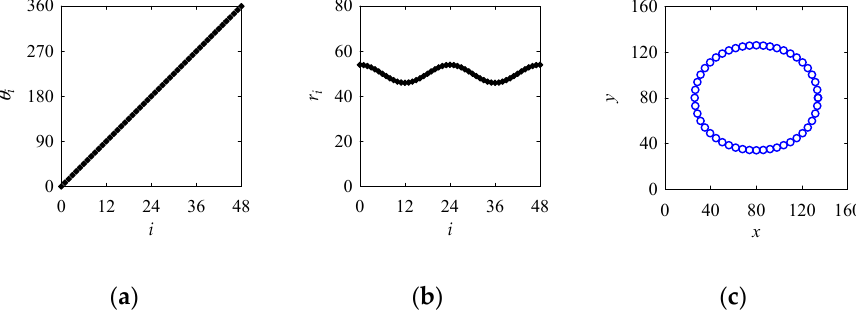
Figure 7. Settings for an ellipse using the PCA. ( a ) Input1: θ i ; ( b ) Input2: r i ; ( c ) Output: Point cloud.